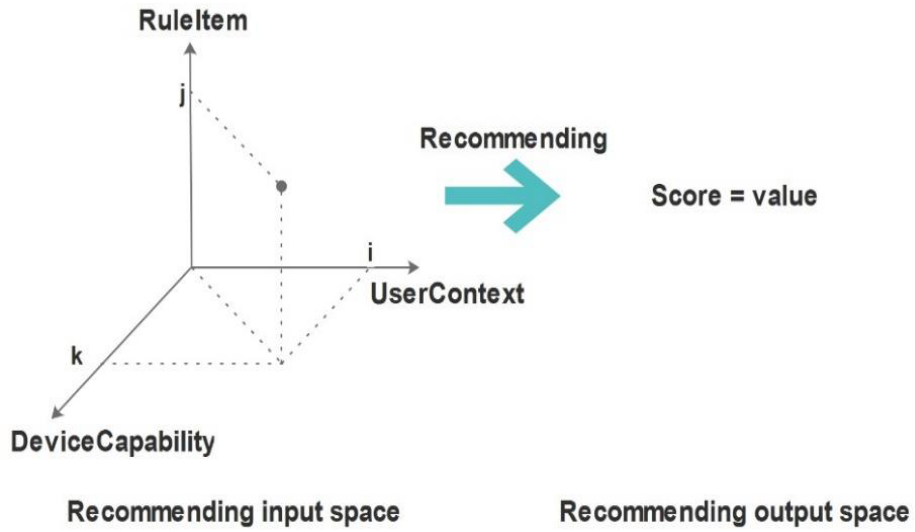
Figure 1. Proposed multidimensional recommendation space.